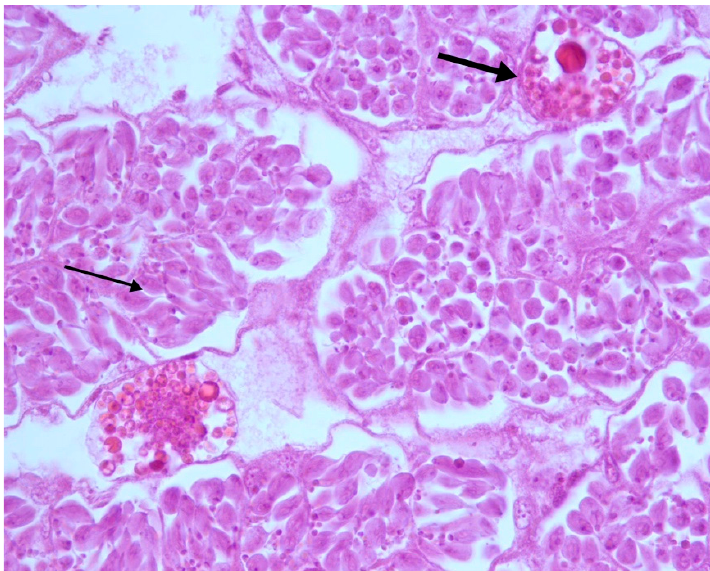
Figure 3 . Testes. Altered seminiferous tubules. Absence of tubular lumen; presence of numerous spermatogonia (thin arrow); absence of spermatozoa; trophocytes between the tubules (thick arrow). H-E 40×.